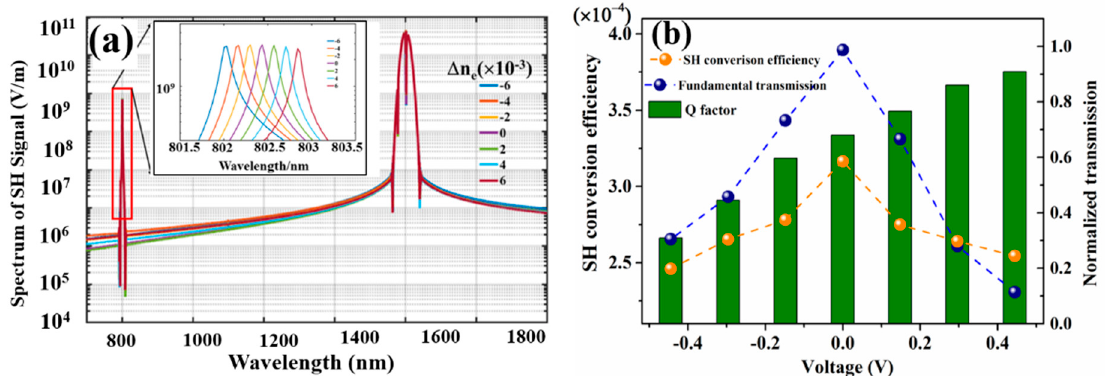
Figure 5. ( a ) Second harmonic signal calculated with different ∆ n e of LN. The inset is a magnified view of SH signal highlighted by red rectangle. ( b ) Quantification of the transmittance (blue spheres), Q (olive columns) at the fundamental wavelength of 1605 nm and the conversion efficiency η of the SH signal (orange spheres) corresponding to ( a ) where the variable ∆ n e has been transformed into external applied voltage U via the EO effect of the LN.